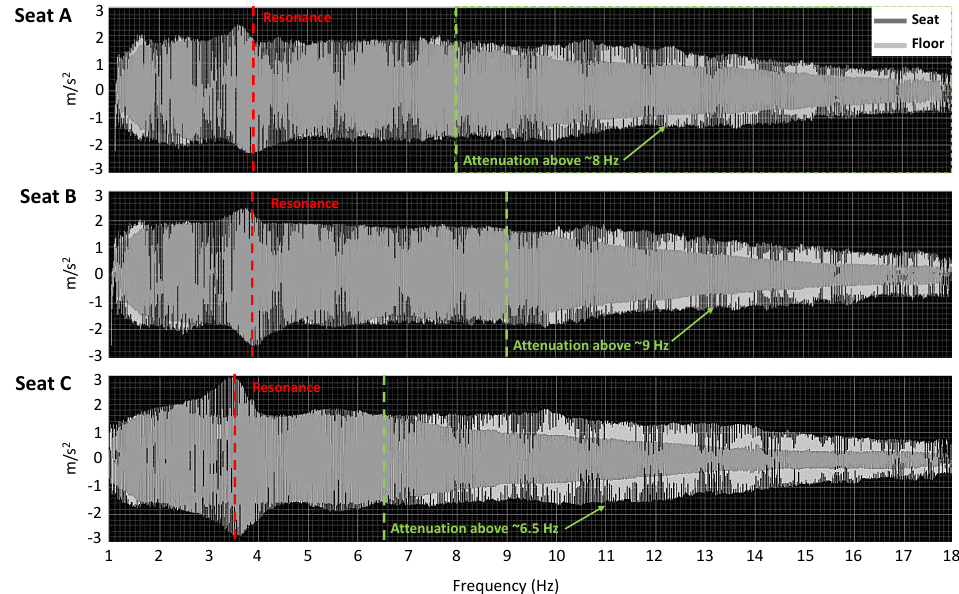
Figure 7. Representative Z-axis 1.5 m/s 2 sine sweep from one subject. Red dashed lines indicate resonant frequencies; green lines indicate frequencies from which the floor-measured vibration is attenuated.